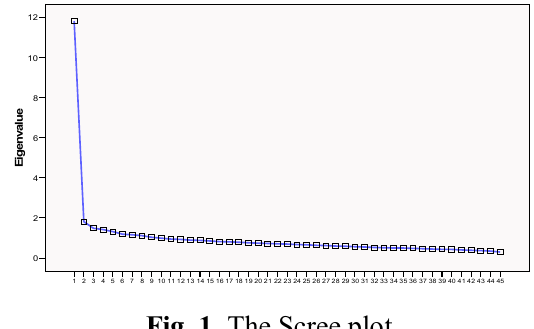
Fig. 1. The Scree